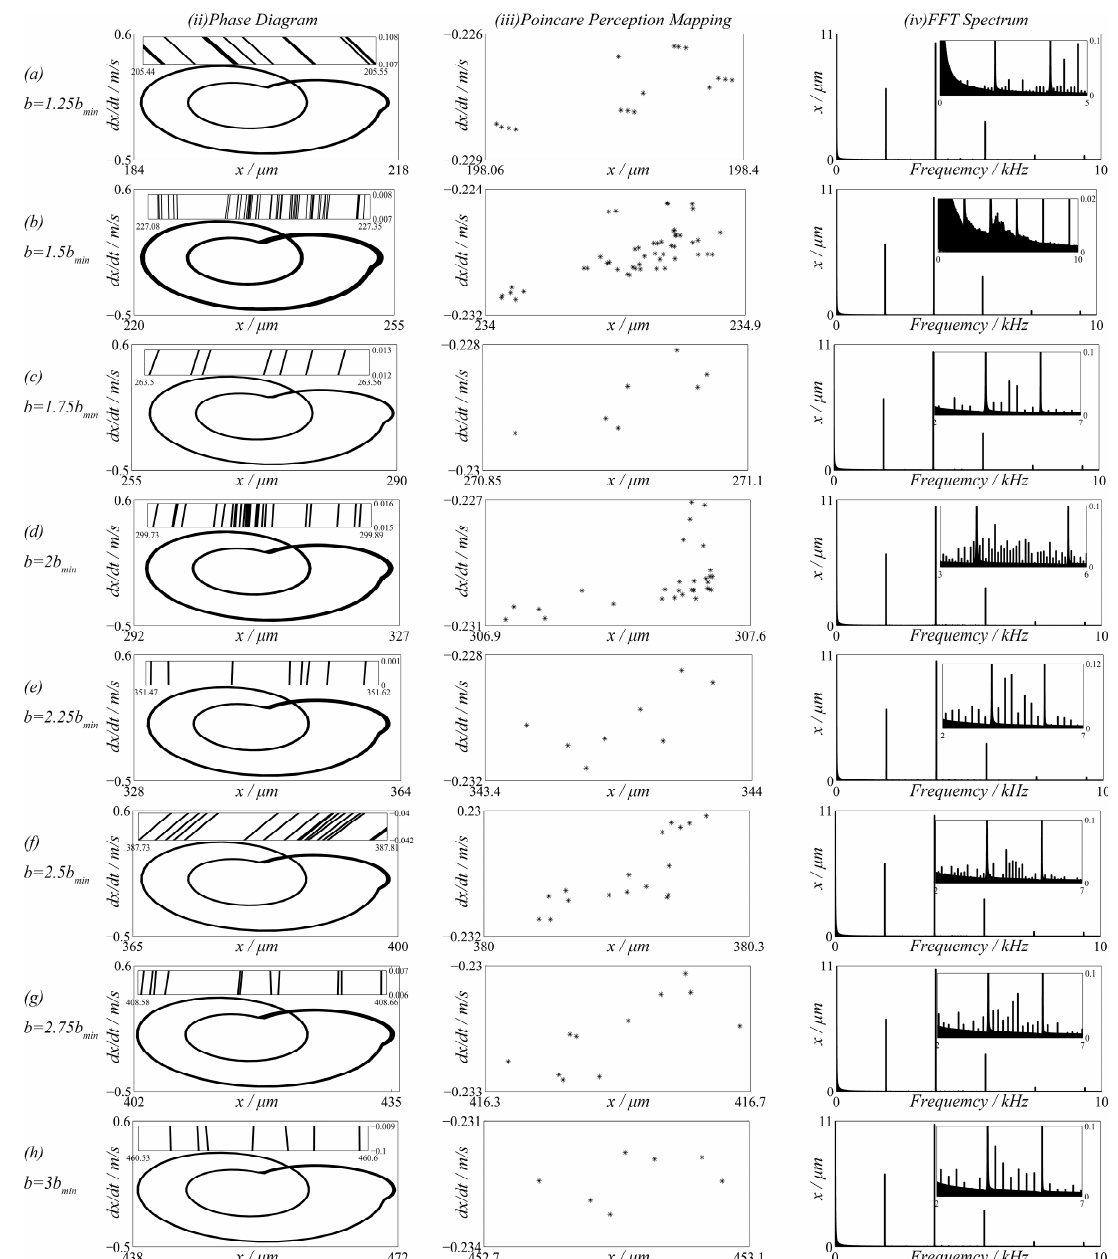
Figure 10. The system response in terms of the dynamic transmission error of various backlash. ( a ) b = 1.25 b min ; ( b ) b = 1.5 b min ; ( c ) b = 1.75 b min ; ( d ) b = 2 b min ; ( e ) b = 2.25 b min ; ( f ) b = 2.5 b min ; ( g ) b = 2.75 b min ; ( h ) b = 3 b min